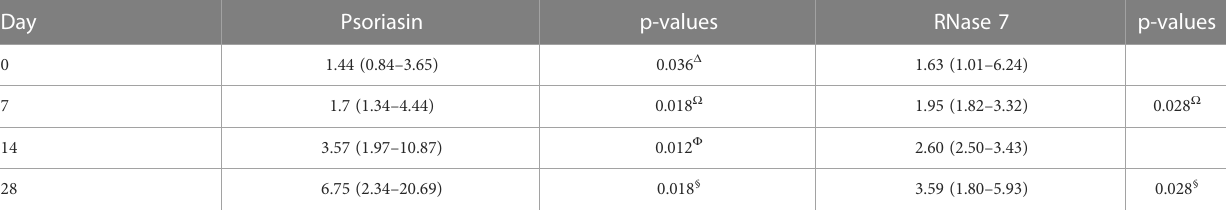
TABLE 3 Median (IQR) concentrations of psoriasin and RNase 7 in premature infants after exclusion of infants with chorioamnionitis and/or